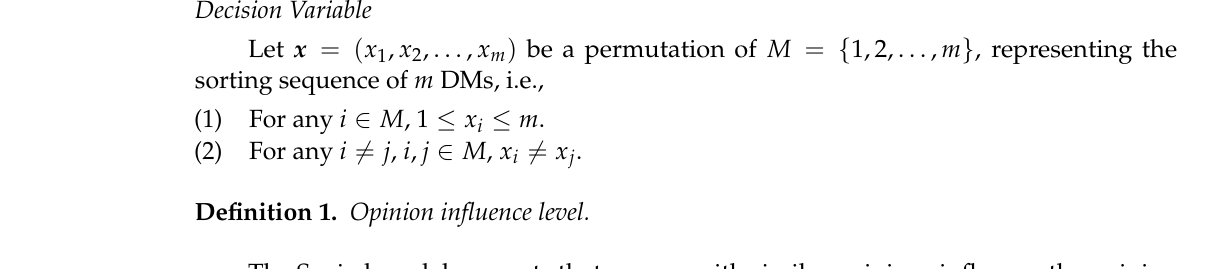
Figure 1. A framework of sorted cost consensus negotiation. Decision